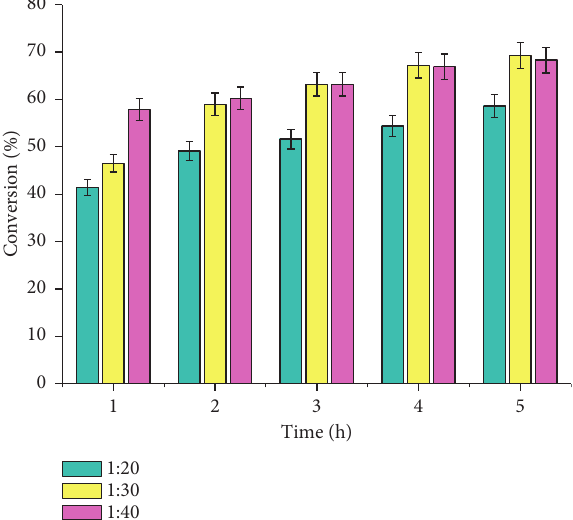
Figure 8: The effect of substrate molar ratio on the oleic acid conversion over the HPW@CoCeO